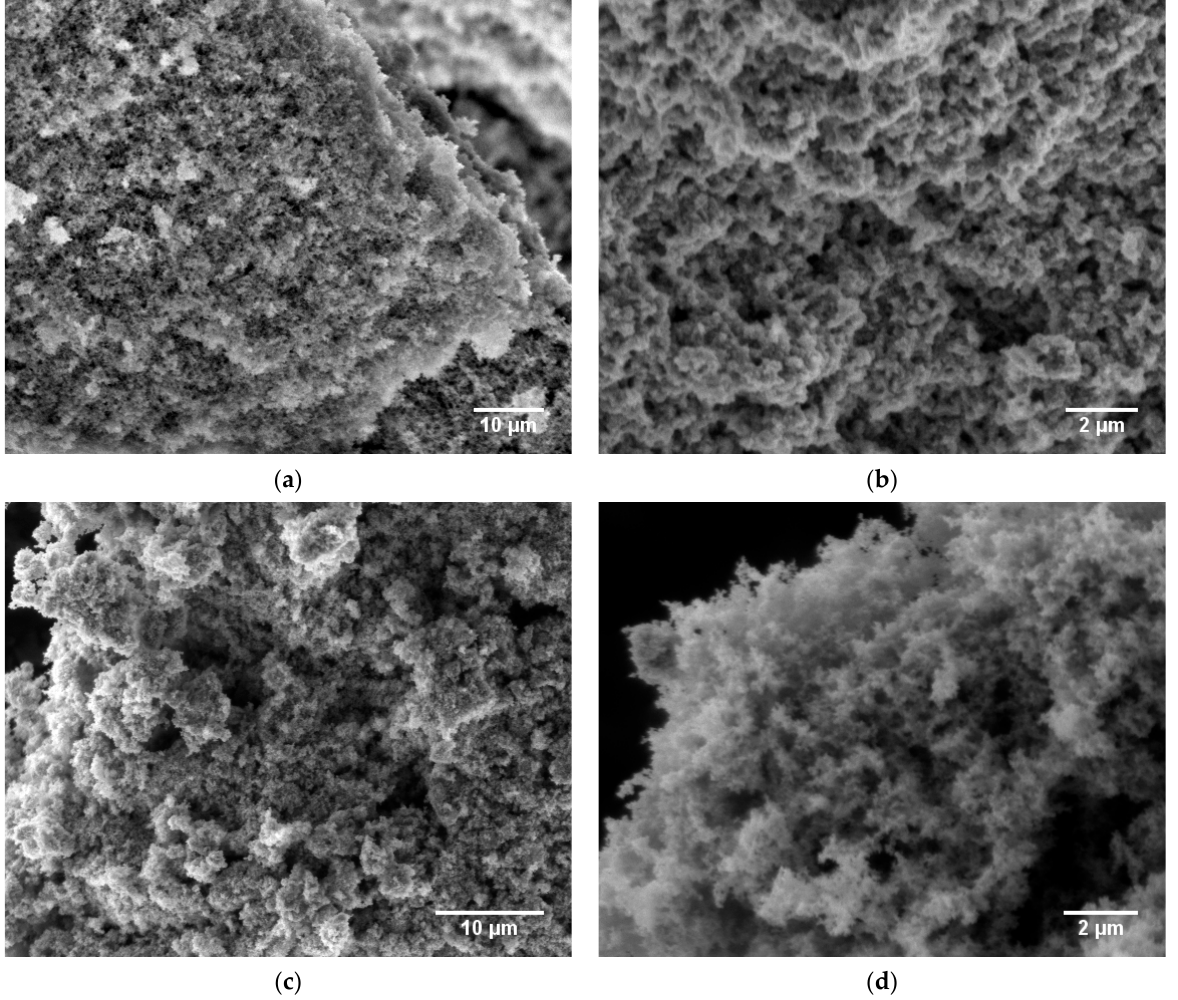
Figure 5. SEM micrographs of ITO aerogel A samples as obtained directly after CPD ( a , b ) and after annealing at 400 ◦ C for 2 h in air ( c , d ) at different magnifications. HRTEM images of the untreated aerogel (Figure 6a,b) and the aerogel after